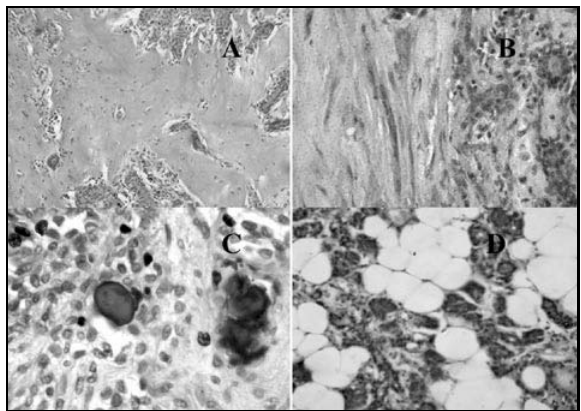
Figura 3 – A: Hialinização (HE, 100x); B: fibrose (HE, 400x); C: calcificação (HE,400x); D: infiltração adiposa (HE,